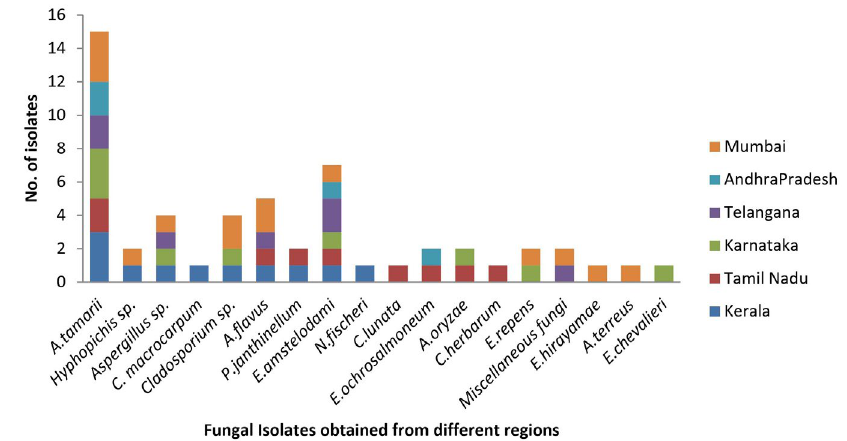
Fig. 1. Isolates of fungal genera from stored red